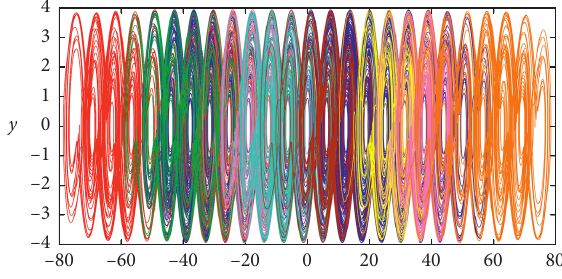
Figure 1: Different coexisting attractors of the FOPLL system for K � 2.8 and G � 1 with fractional order q � 0.98. The initial conditions are y � 0 and z � 0 with x initial condition varying from − π to + π with a step size of π /5.